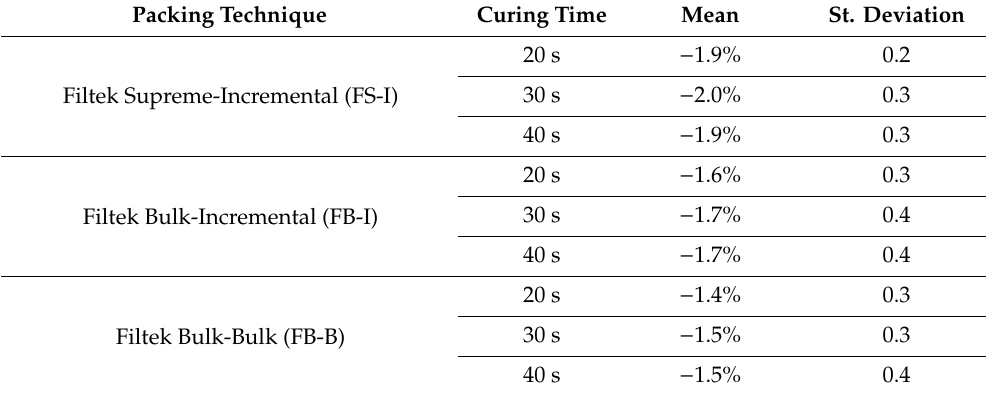
Table 3. Mean ± SD values of polymerization shrinkage for di ff erent packing techniques and curing times.